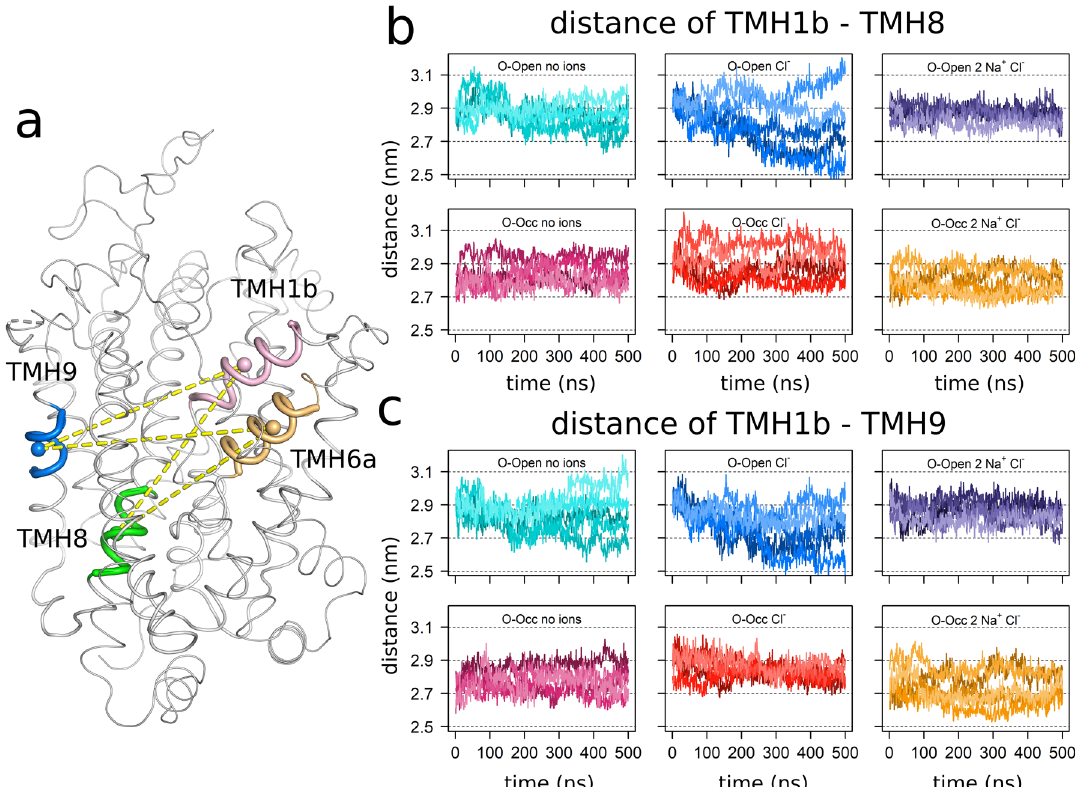
Figure 2. Bound ions stabilize transmembrane helix 1b (TMH1b). ( a ) Graphical legend highlighting the measured distances. The center of mass of TMH1b (residues 99–111), TMH6a (residues 328–338), TMH8 (residues 442–450), and TMH9 (residues 471–477) were used for measurements. These are highlighted as spheres. The time evolutions of the distances between TMH1b and TMH8 ( b ) and between TMH1b and TMH9 ( c ) are shown. All data were sampled with a 1 ns temporal resolution. The respective distances from TMH6a are shown in Supplementary Figure S1.